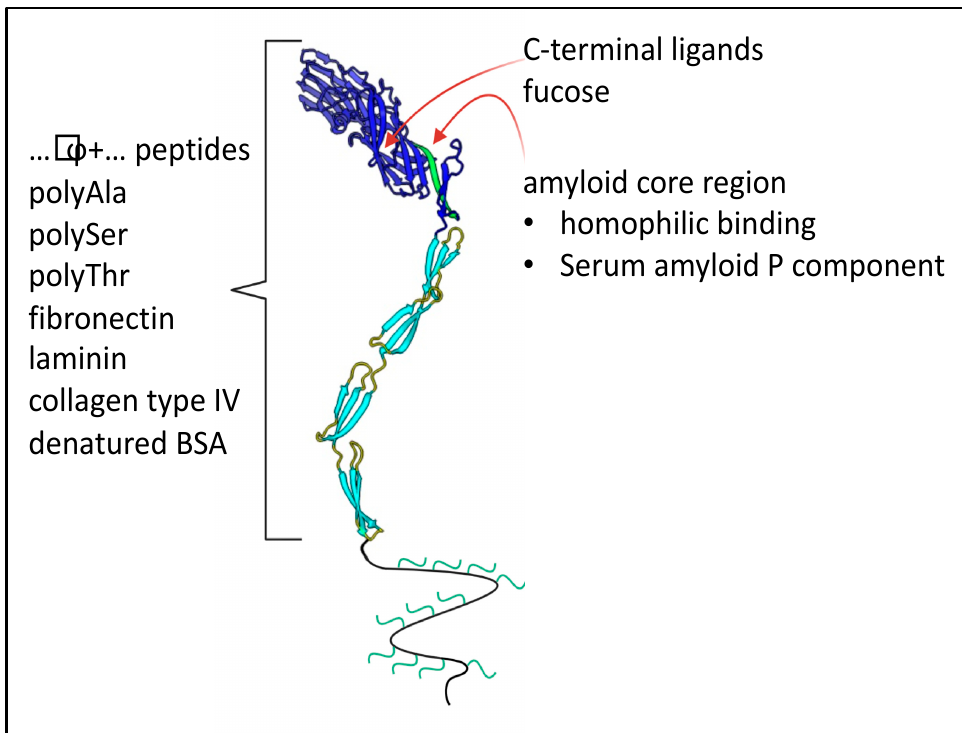
Figure 6. Binding partners of C. albicans Als adhesins. The model shows the two N-terminal Ig-like domains in dark blue, with the binding cleft between them. Three tandem repeats in the T region and two of many repeats in the TR regions are shown in light blue. The unstructured C-terminal stalk region is shown as a wavy line with attached glycans in green. This region typically consists of 600–1000 residues.